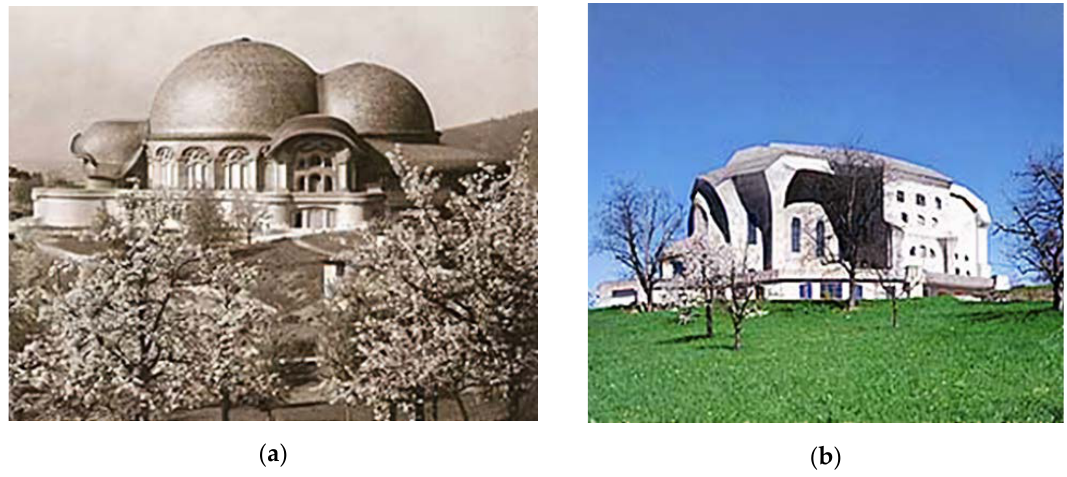
Figure 1. ( a ) Goetheanum of 1913–1920; ( b ) Goetheanum of 1925–1928 [19].